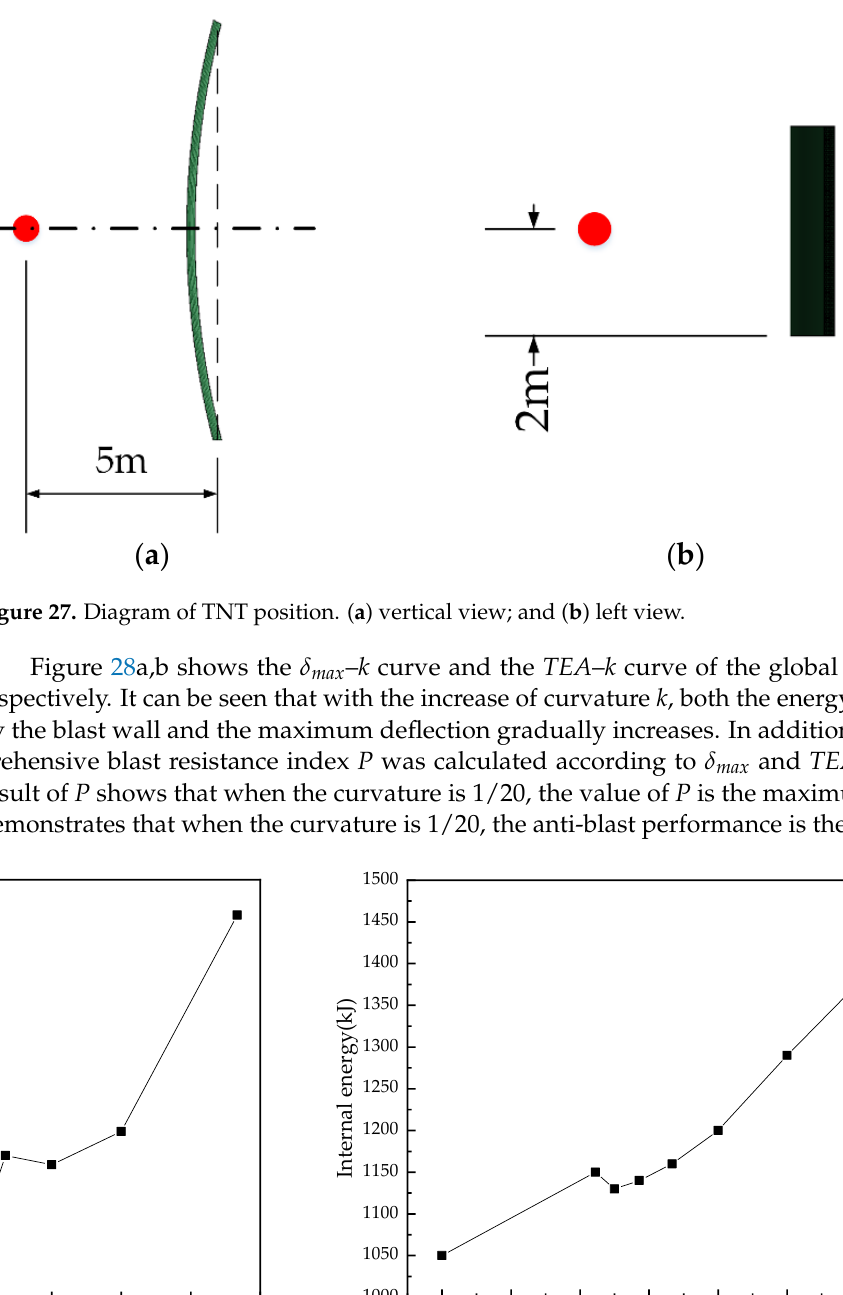
Figure 26. Configurations of blast wall with different curvature (m − 1 ).